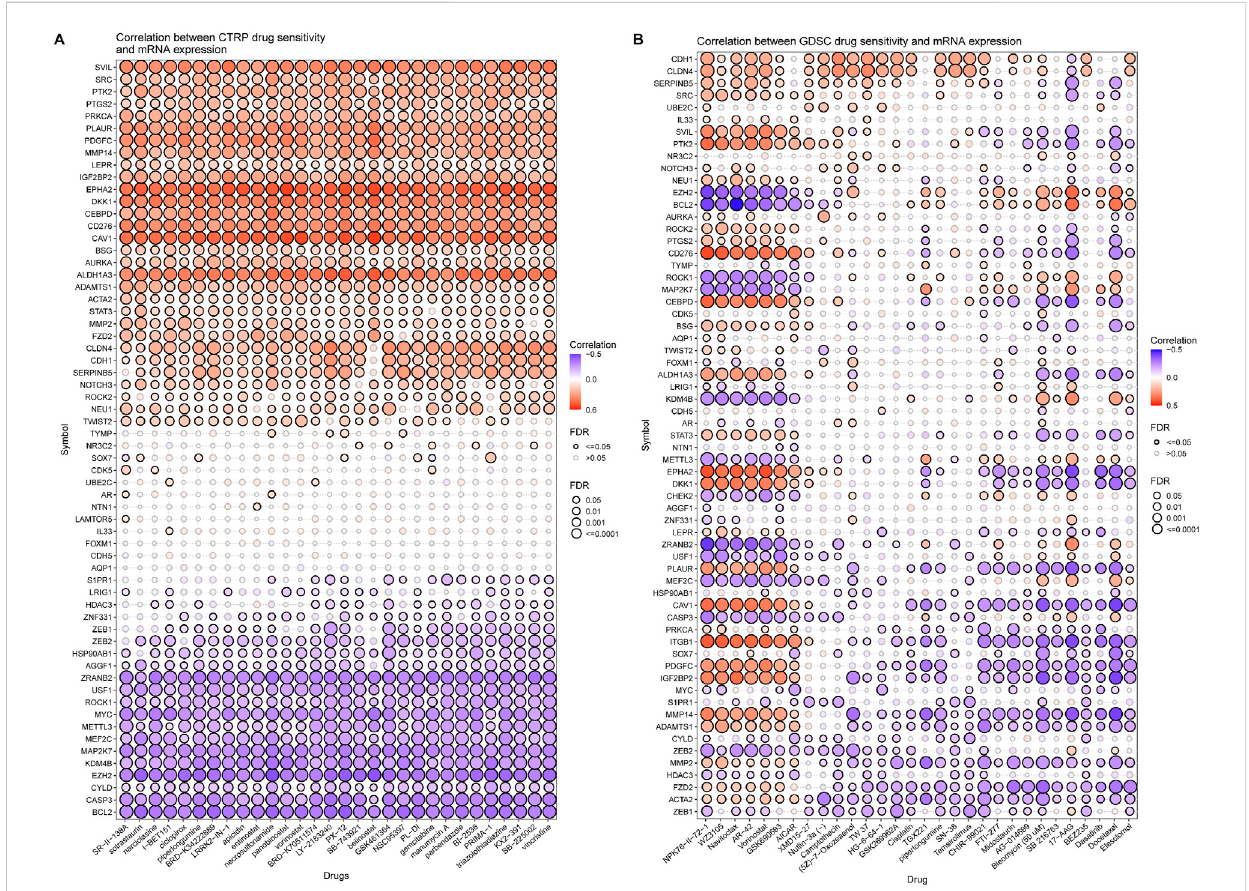
FIGURE 8 Correlation analysis between VM-related DEGs and drug sensitivity (top30 drugs in GDSC and CTRP). (A, B) Bubble chart shows the correlation analysis between VM-related genes and drug susceptibility. Red indicates positive correlation and blue indicates negative correlation. The darker the color, the higher is the correlation index. Bubble size indicates